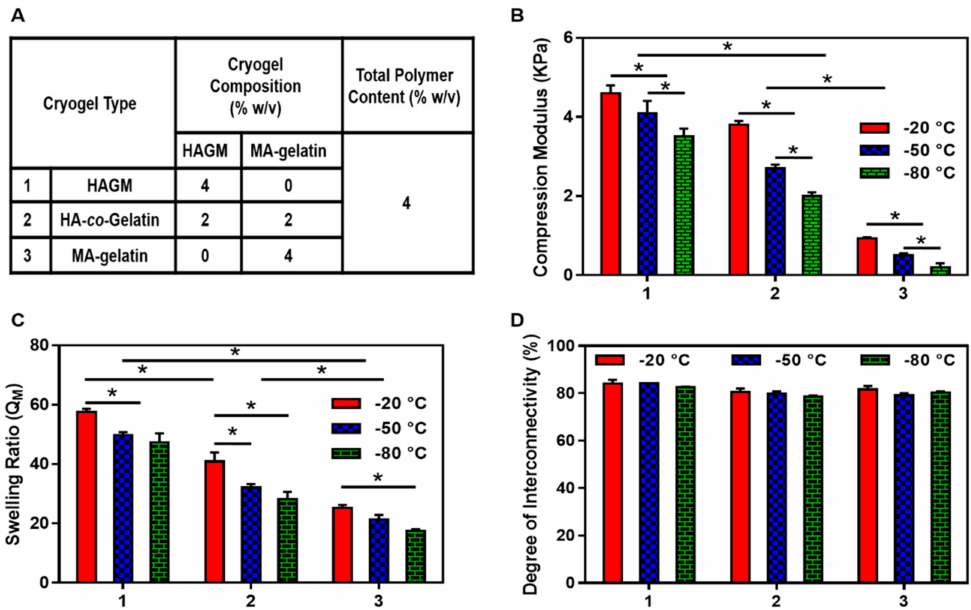
Figure 3. Physical characterization. ( A ) Cryogel type and composition; ( B ) compression moduli; ( C ) swelling ratios; and ( D ) degrees of pore interconnectivity of HAGM, MA-gelatin, and HA- co -Gelatin cryogels fabricated at − 20, − 50 and − 80 ◦ C. Values represent mean and SD ( n = 5). Data were analyzed using one-way analysis of variance (ANOVA) (* p <